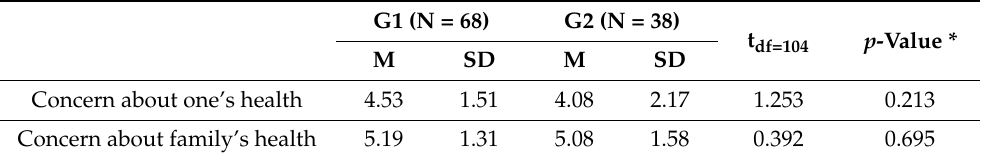
Table 5. Motivation to vaccinate in groups G1 and G2.